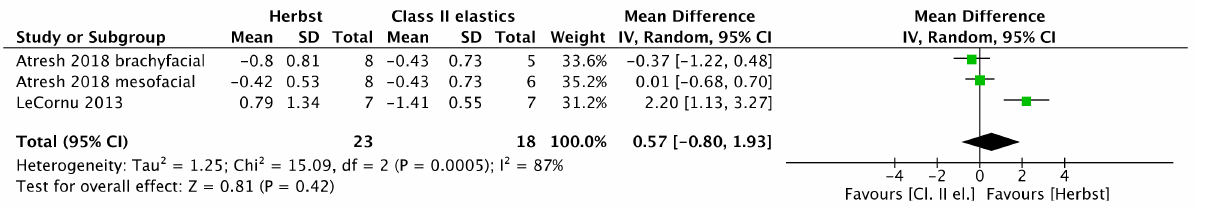
Figure 25. Forest plot of left posterior glenoid fossa anteroposterior changes using the random effects model [43,44].